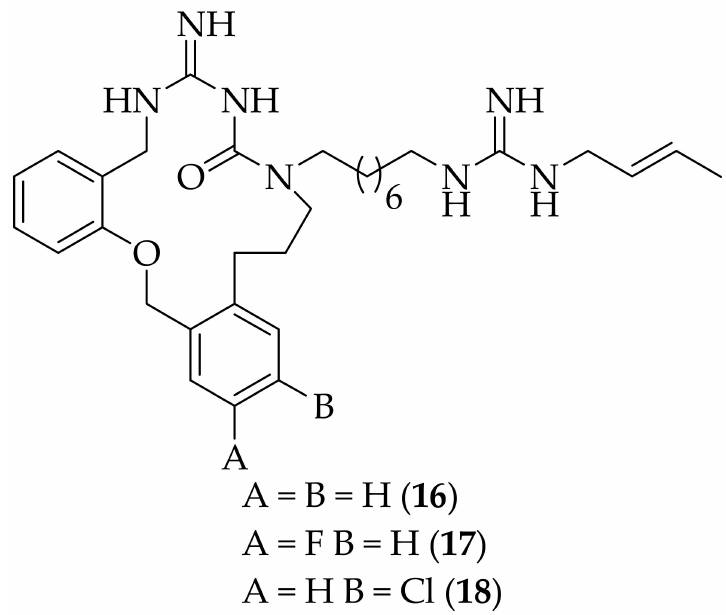
Figure 9. Arylated derivatives ( 16 ), ( 17 ), and ( 18 ) of cyclized guazatine-derived analog ( 13 ).